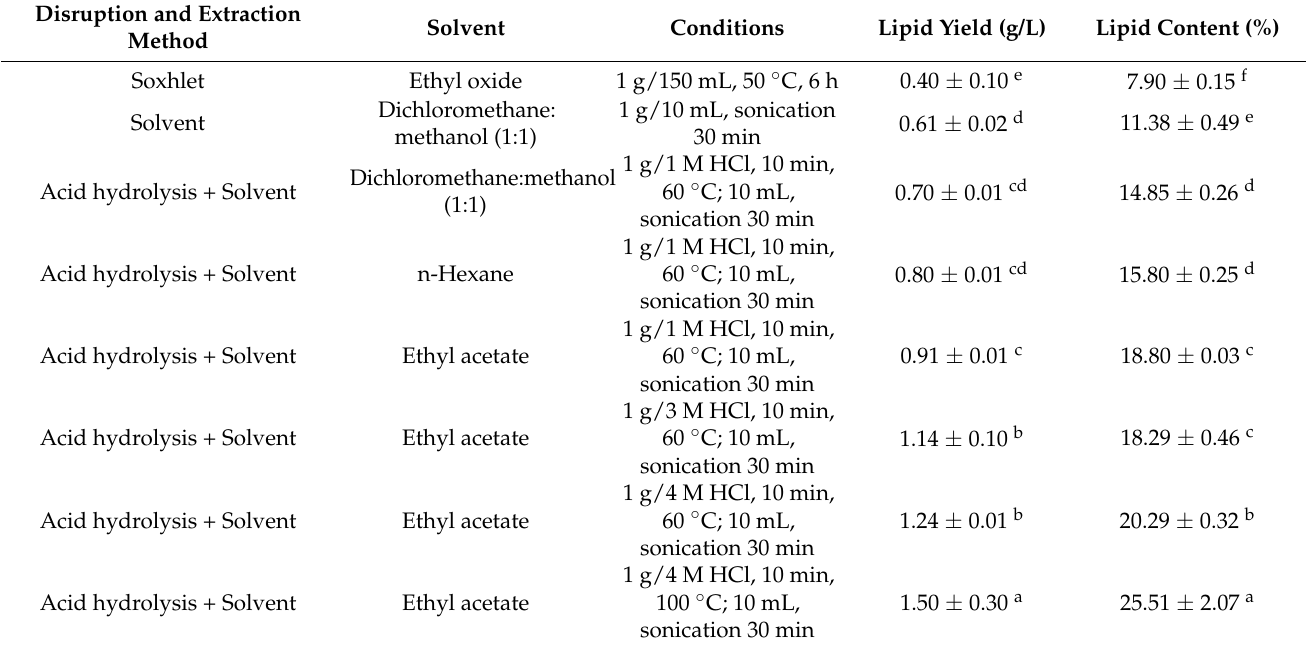
Table 1. Comparison of R. mucilaginosa lipid content obtained with the acid hydrolysis and different solvents of extraction conditions.